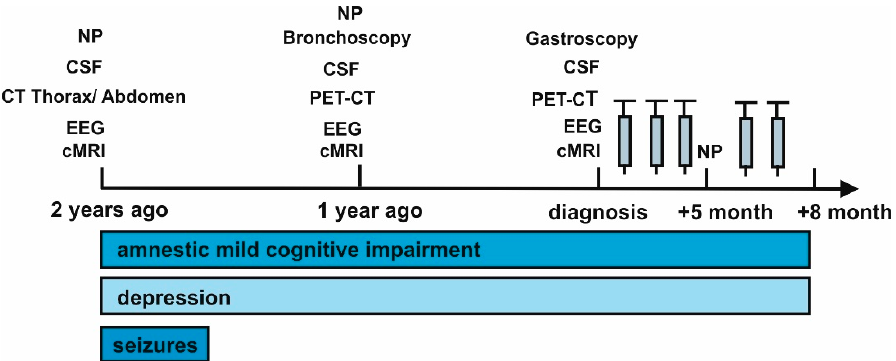
Figure 1. Time course of symptoms evolution. Abbreviations: CSF = cerebrospinal fluid, cMRI = cranial magnetic resonance imaging, CT = computed tomography, EEG = electroencephalography, NP = neuropsychological testing, PET CT = positron emission tomography computed tomography, electroencephalography, and PET CT = positron emission tomography computed tomography. The gray syringes indicate the corresponding methylprednisolone cycles.